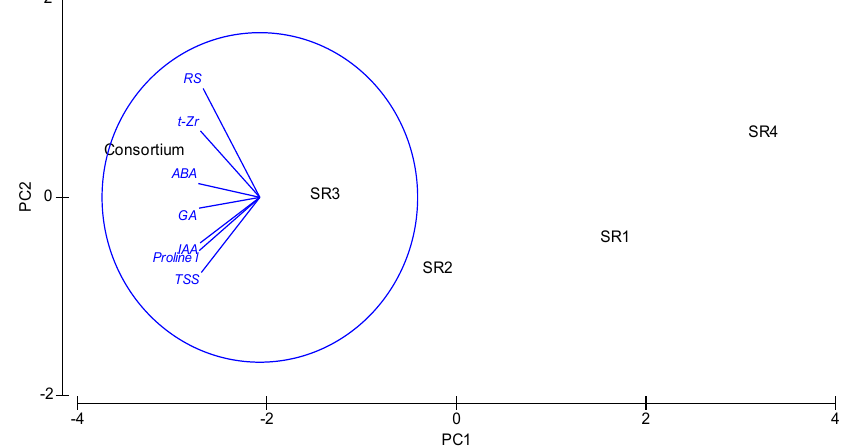
Figure 5. Principle component analysis (PCA) of phytohormones, proline, total soluble sugars, and reducing sugars of halotolerant bacterial isolates and their consortium grown under salt stress in culture conditions. Whereas, IAA = Indole acetic acid, GA = gibberellic acid, CK = Trans zeatin riboside, RS = Reducing sugars, TSS = Total soluble sugars.